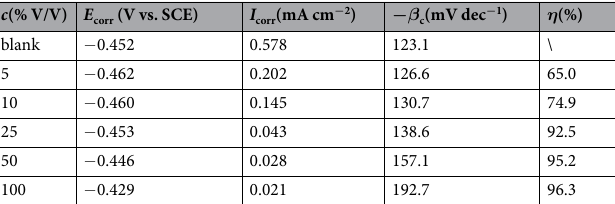
c (% V/V) E corr (V vs.